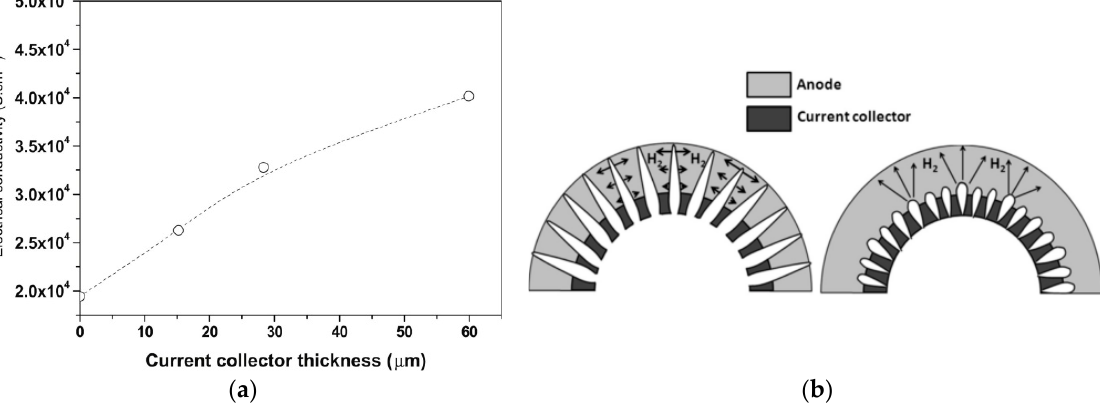
Figure 12. ( a ) Electrical conductivity as a function of current collector thickness [114]. ( b ) Cross-section schematic of dual-layer hollow fibre cell with mesh/finger-like protrusions for enhanced mass transport [114].